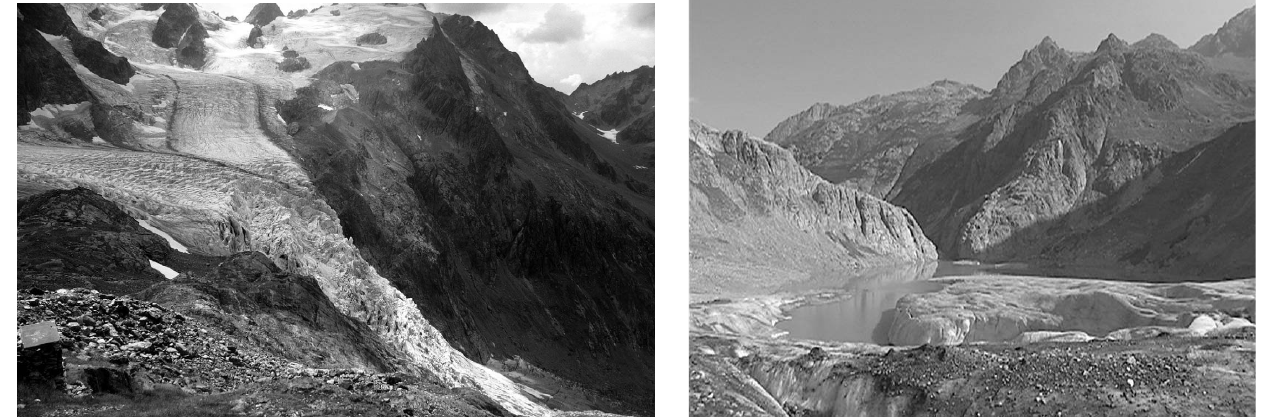
Fig. 2. Steep part of Triftgletscher in 2003 (35 ◦ , left) and the riegel with the narrow gorge through which Triftwasser drains the basin (2004) (photos M.